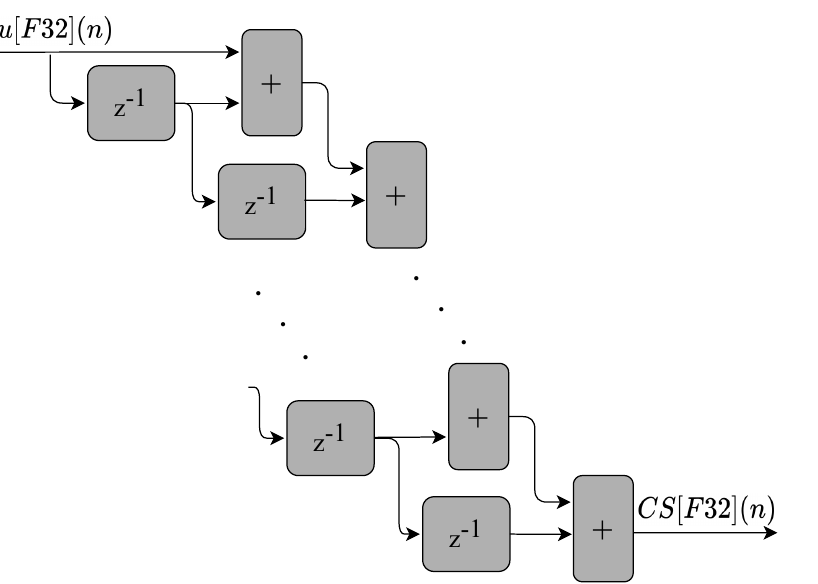
Figure 8. Block diagram representing the circuits used to implement the cascading sum ( CS ) hardware module. It receives u [ F 32 ]( n ) as input value (generated in the previous multiplier), and outputs the CS [ F 32 ]( n ) value.